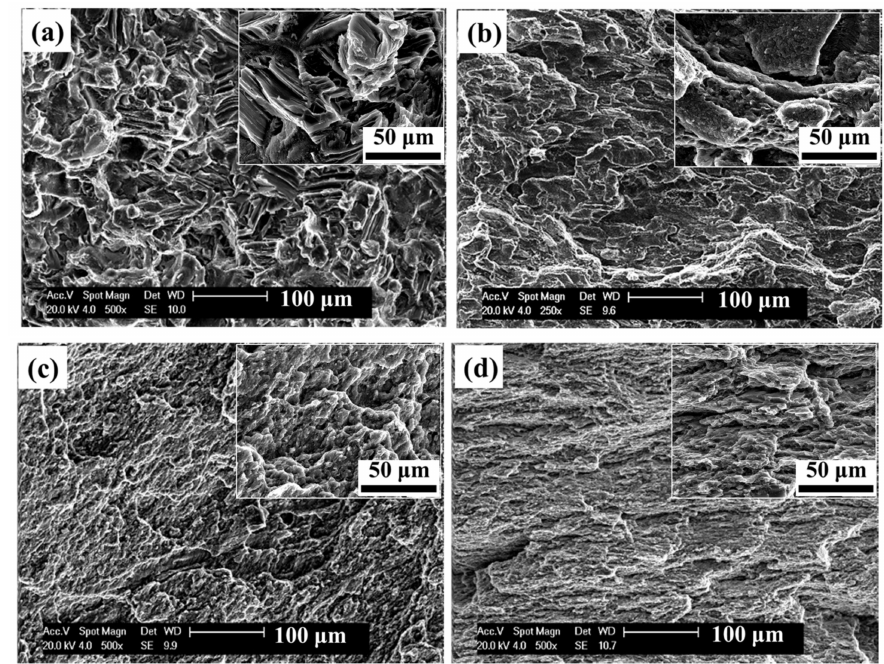
Figure 13. SEM images of fracture surfaces of ( a ) As-cast, ( b ) 623 K-4P, ( c ) 623 K-12P and ( d ) 573 K-12P alloys. Insets of the images are the corresponding enlarged